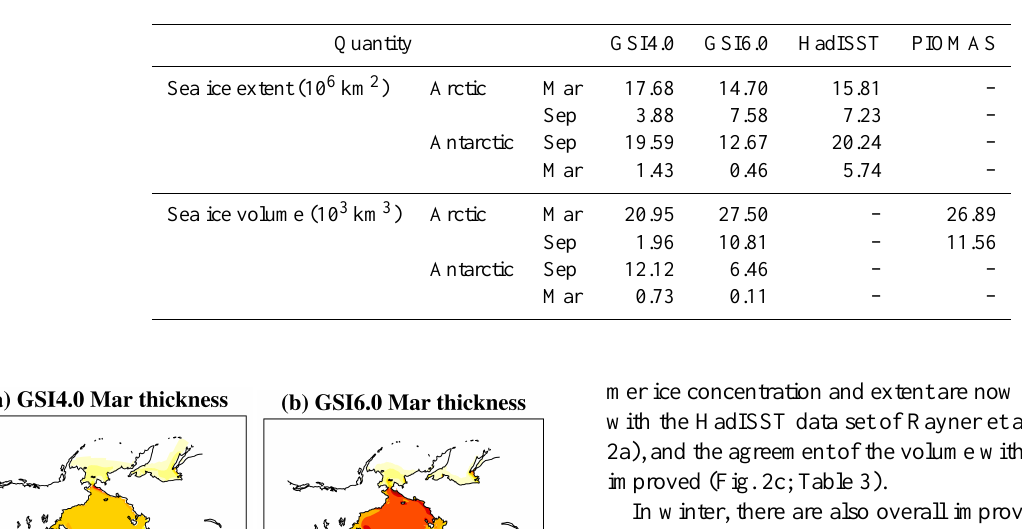
Table 3. 50-year mean sea ice extent and volume in GSI4.0 and GSI6.0, and equivalent 11-year (1995–2004) means for HadISST and PIOMAS data.